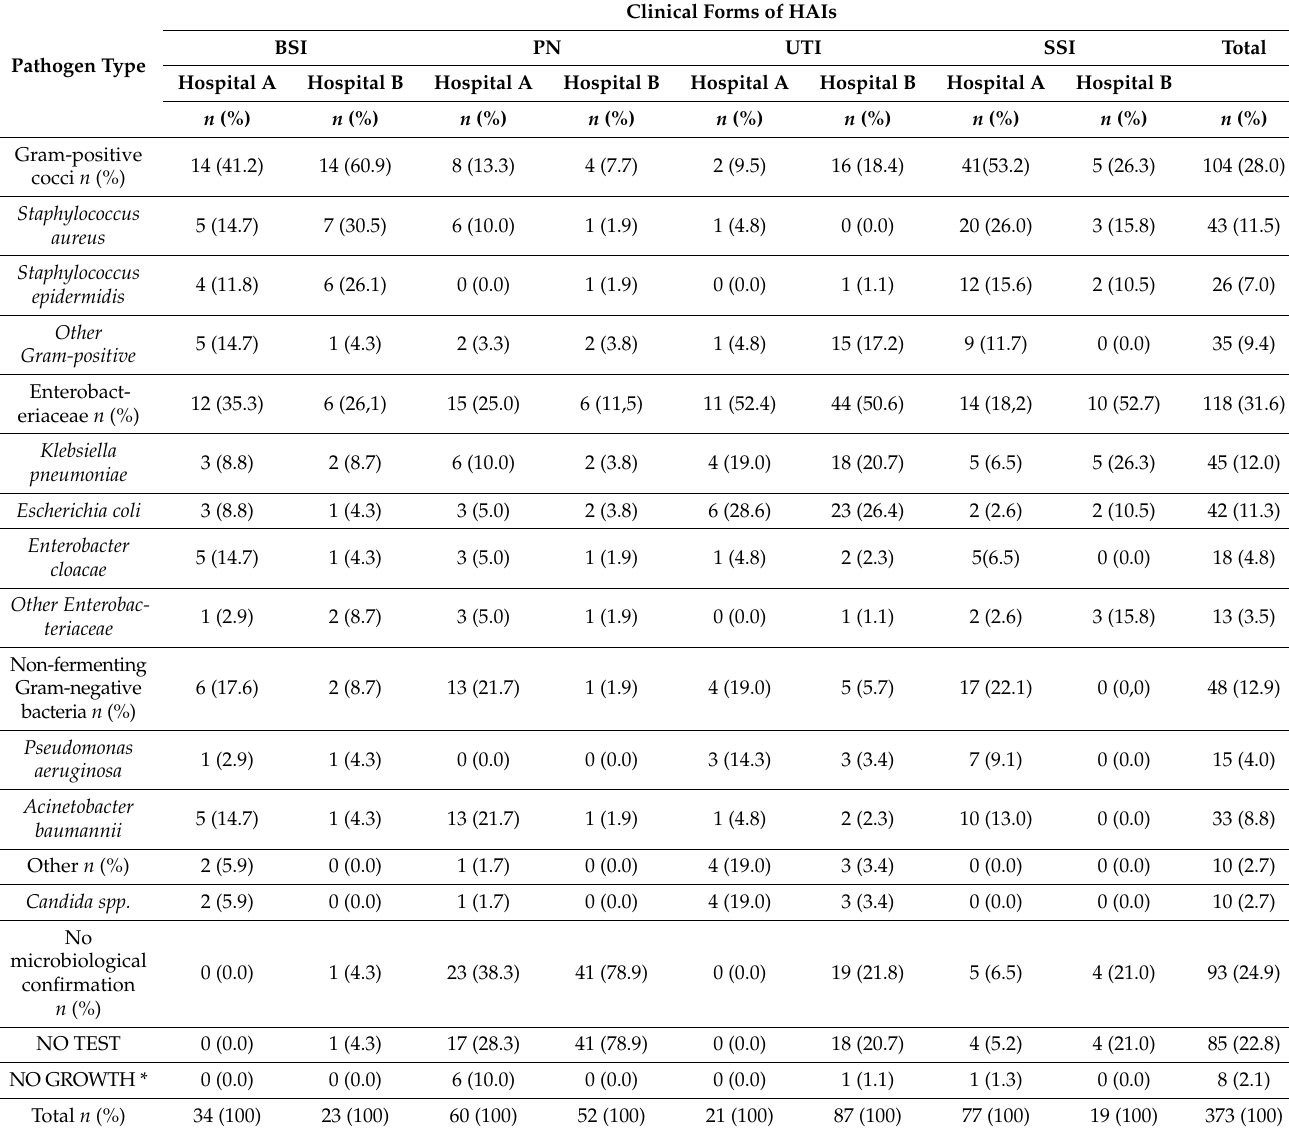
Table 4. Pathogens responsible for HAIs isolated in microbiological studies, and clinical forms of HAIs in neurosurgery in the years